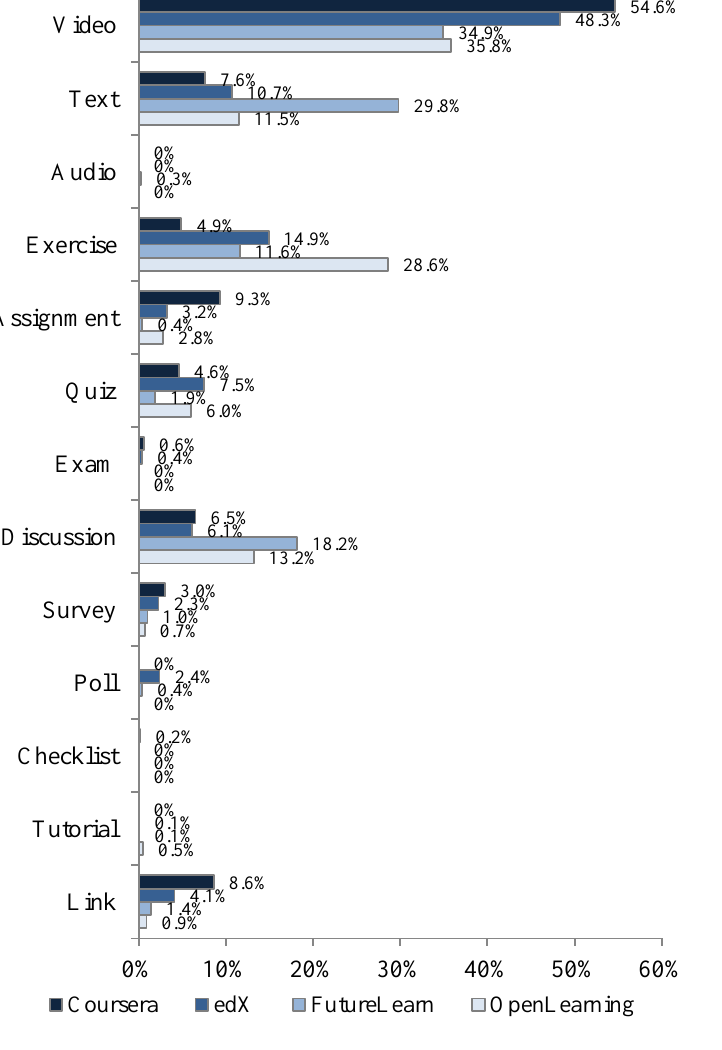
Figure 2 Proportion of teaching components used in the